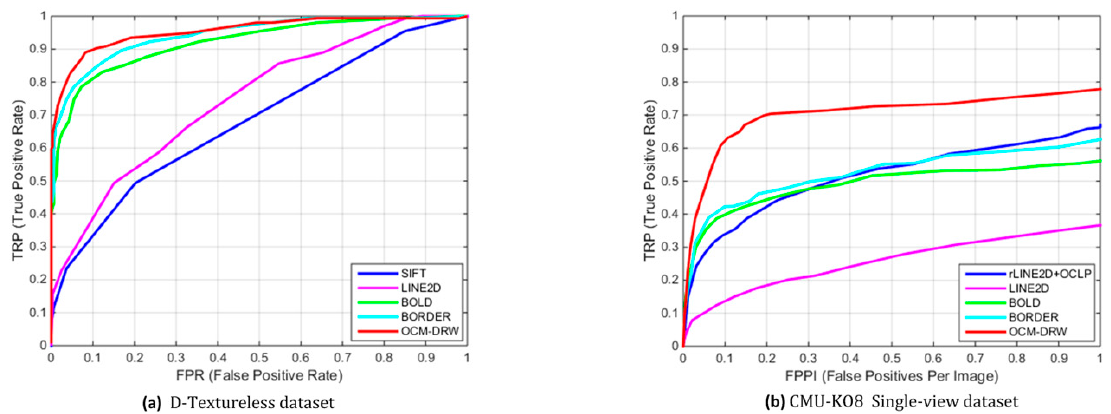
Figure 10. Recognition results using different approaches on texture-less datasets.